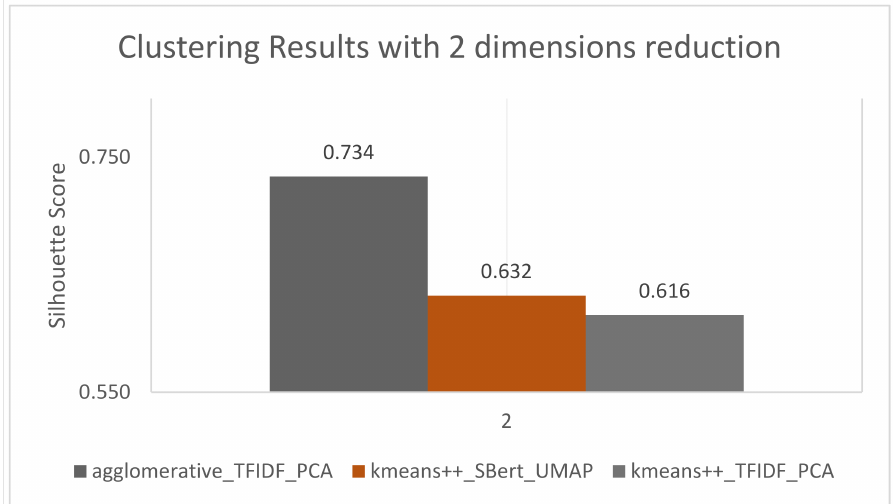
Figure 8. Best clustering results with two dimensions reduction on the baseball